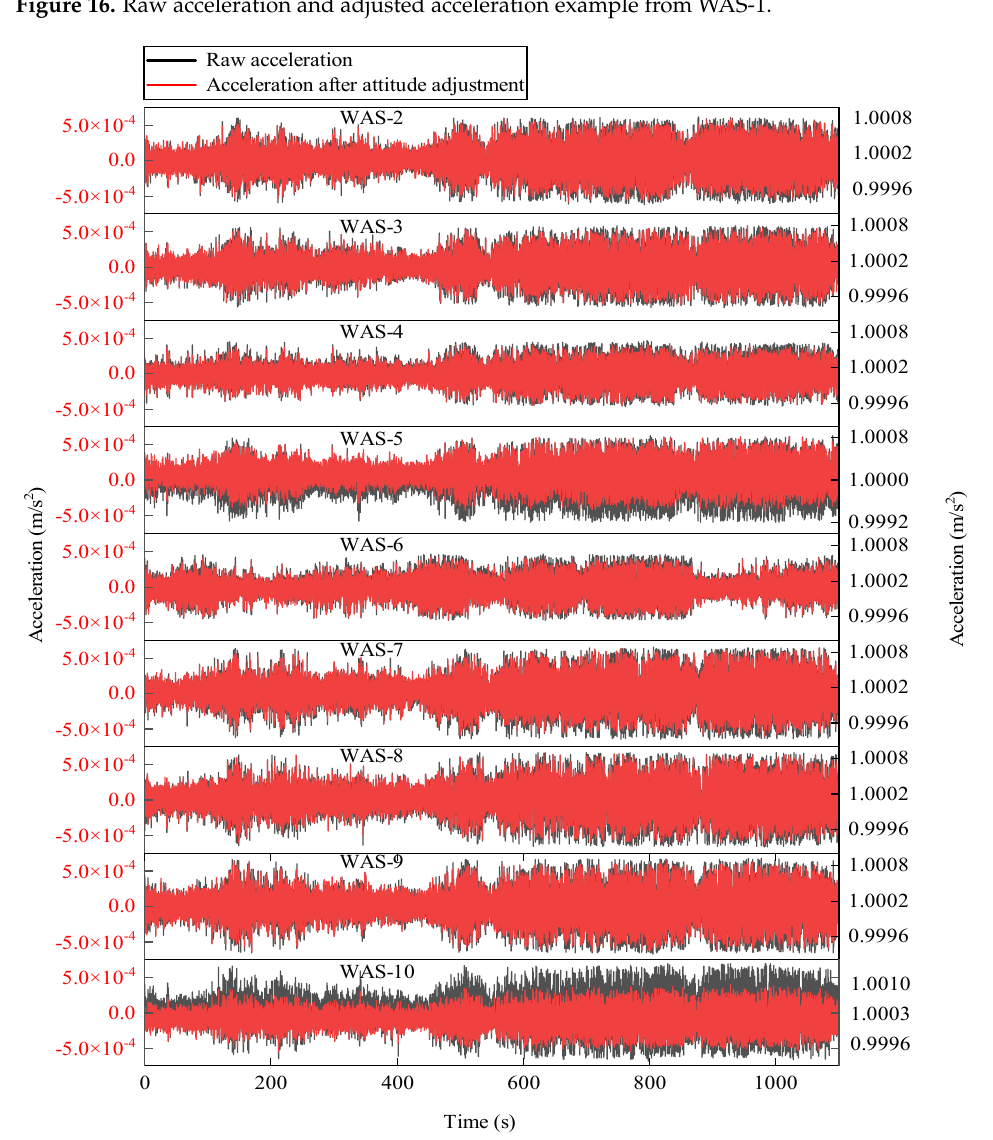
Figure 16. Raw acceleration and adjusted acceleration example from WAS-1.